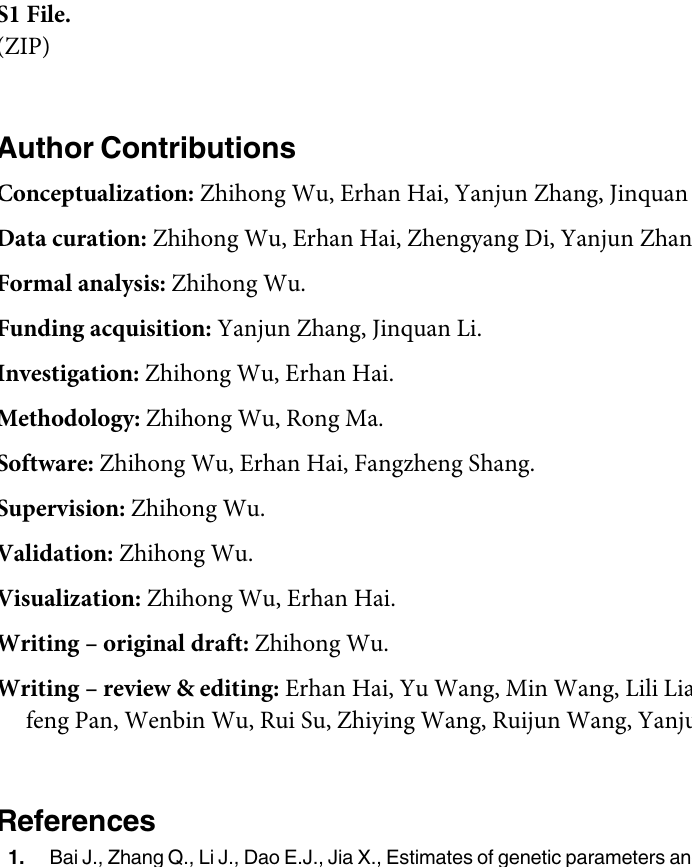
S1 Table. Transcriptome data. The gene expression data for each sample was normalized using the fragments per kilobase of exon per million fragments method. S2 Table. Connectivity of all genes. S3 Table. Module eigenvalue. S4 Table. Correlation between gene and module